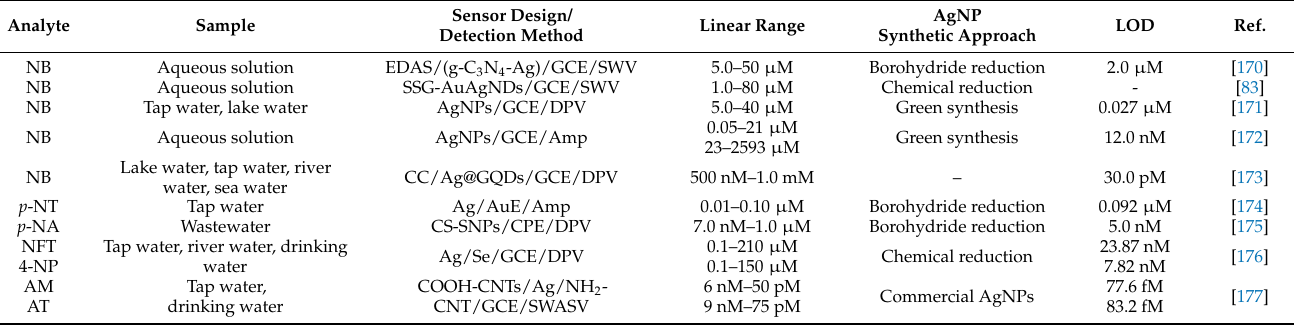
Table 5. Survey of the reviewed silver nanomaterial-based electrochemical sensors for detection of nitroaromatics in water